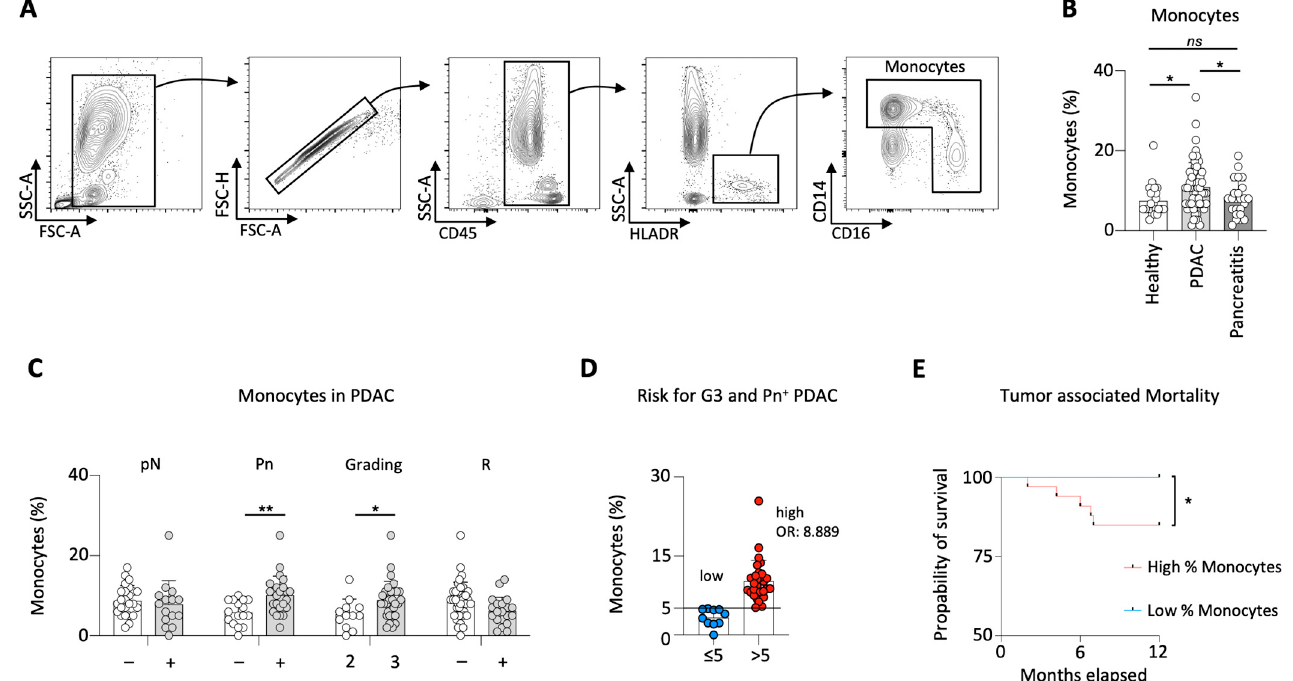
Figure 1. PDAC patients showed increased levels of monocytes. Gating strategy for circulating monocytes ( A ); percentage of circulating monocytes in healthy individuals, PDAC and pancreatitis patients ( B ); percentage of monocytes in PDAC patients correlated to the lymph node status (pN), perineural invasion (Pn), tumor grading (G) and the resection status (R) ( C ); percentage of monocytes (5% identified by minimal p-value approach) defining the risk for G3 and Pn + PDAC patients ( D ); survival analysis for patients with high (>5%) vs. low ( ≤ 5%) monocytes ( E ); * p < 0.05; ** p < 0.01; ns no significance.